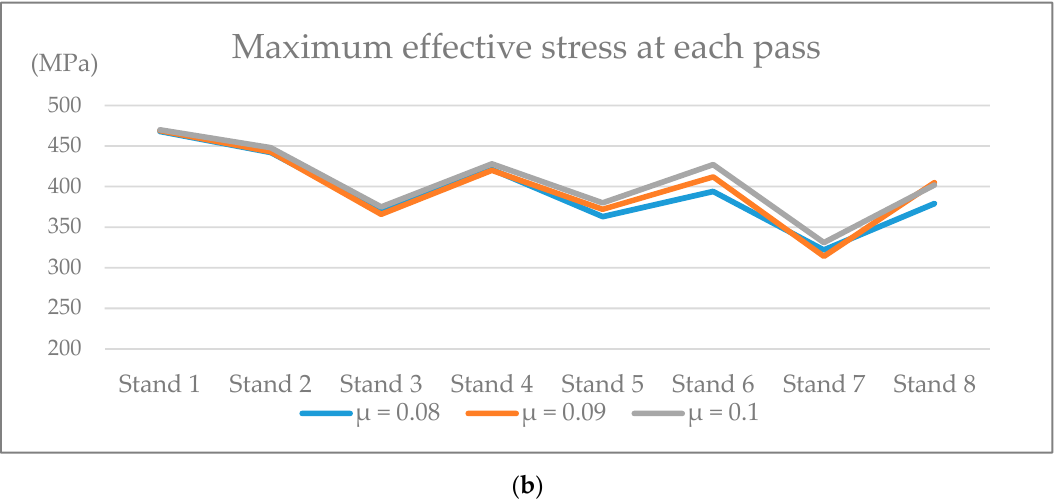
Figure 8. Simulation results calculated at each pass in terms of ( a ) maximum effective strain, ( b ) maximum effective stress. The increasing effect of the coefficient of friction is seen toward the end of the rolling schedule.